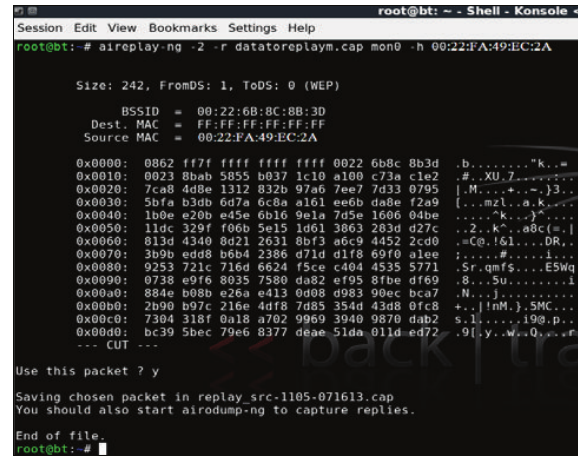
Figure 10: Replay of the encrypted data